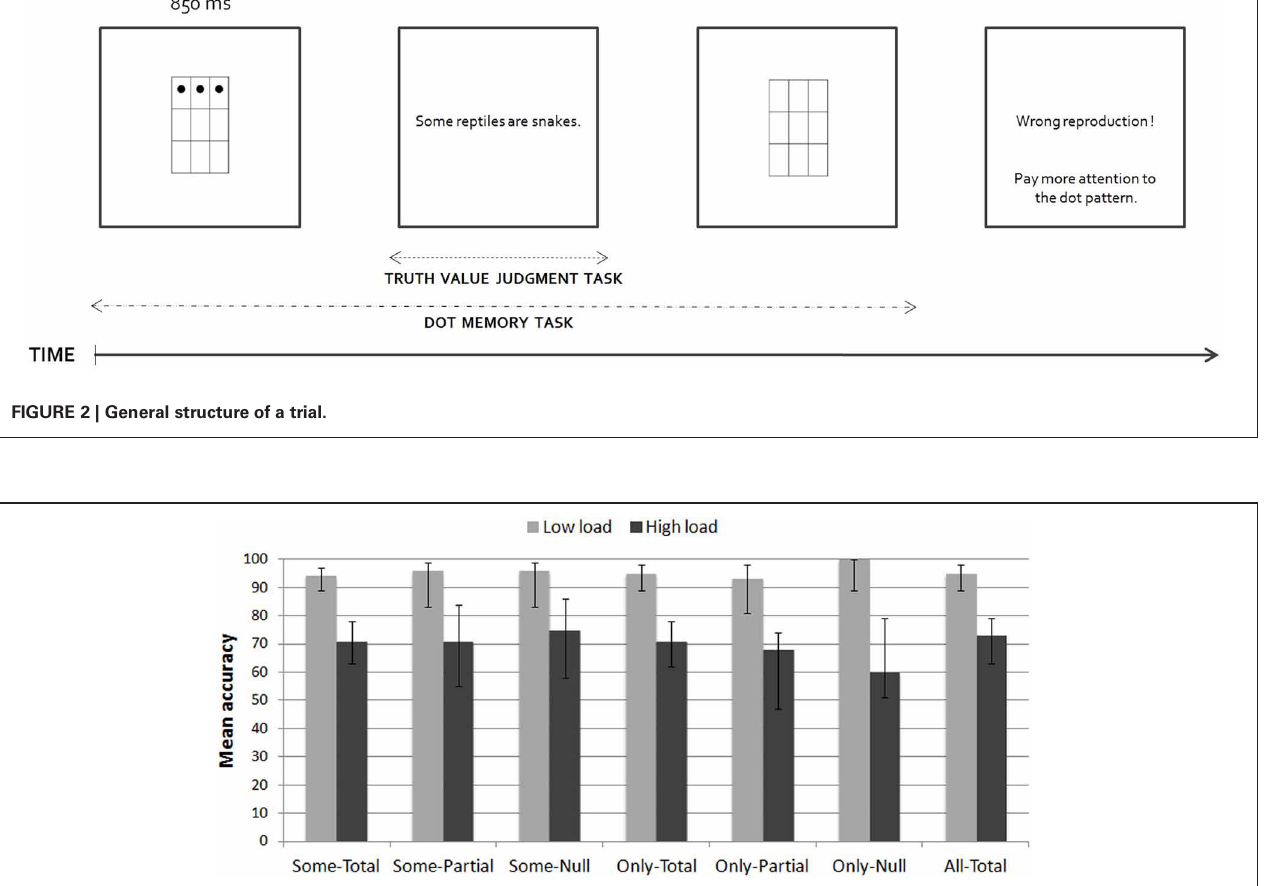
FIGURE 3 | Mean accuracy (in %) to the dot memory task in the LOW LOAD and HIGH LOAD trials as a function of the sentence type presented in the truth-value judgment task. Error bars are 95% confidence intervals estimated from binomial distributions.